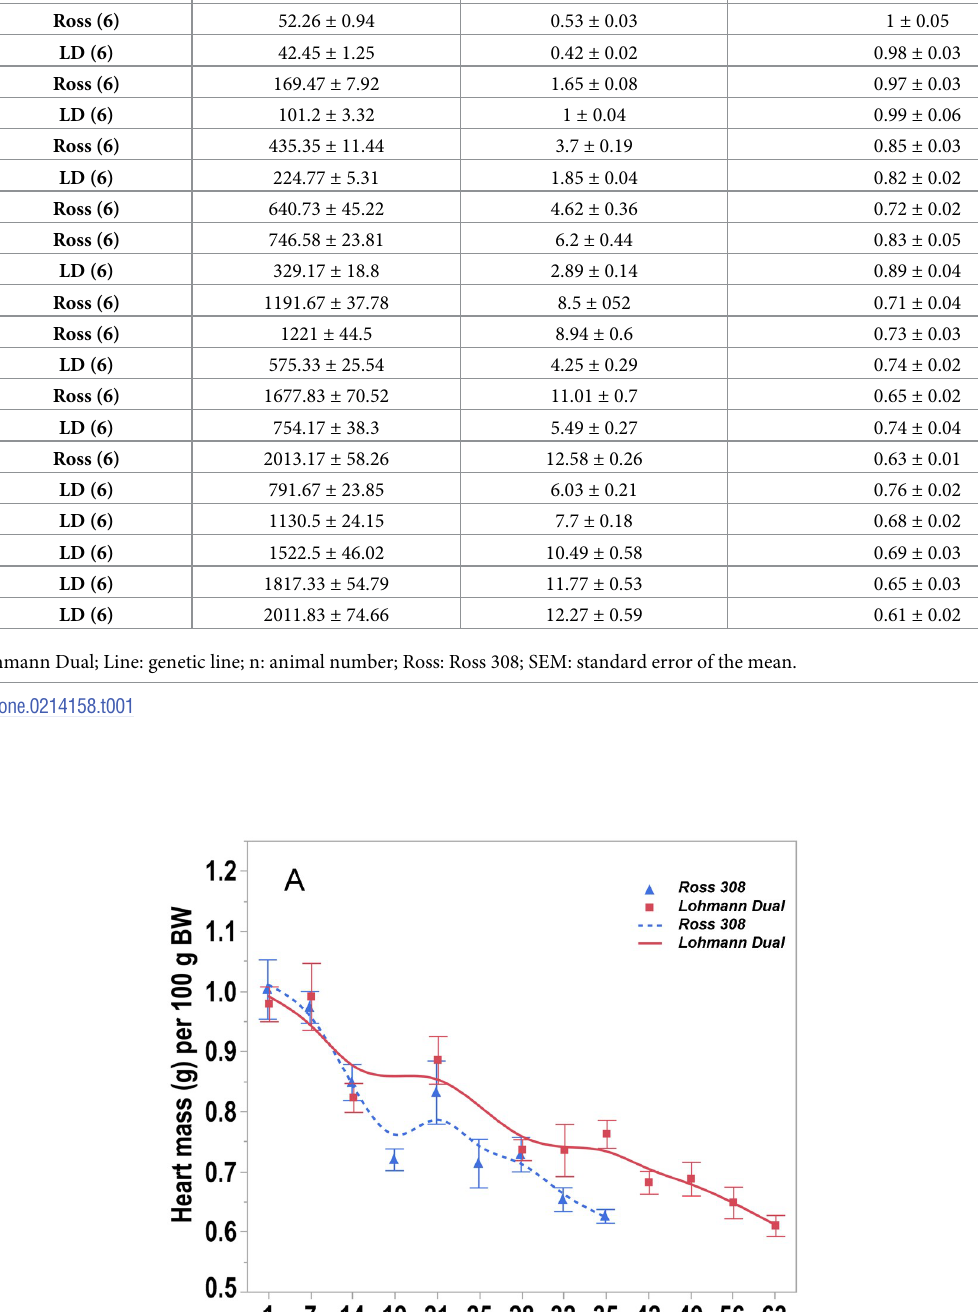
Table 1. Live body weight, heart mass and relative heart mass of LD and Ross chicken lines versus day post hatching. Age (days)